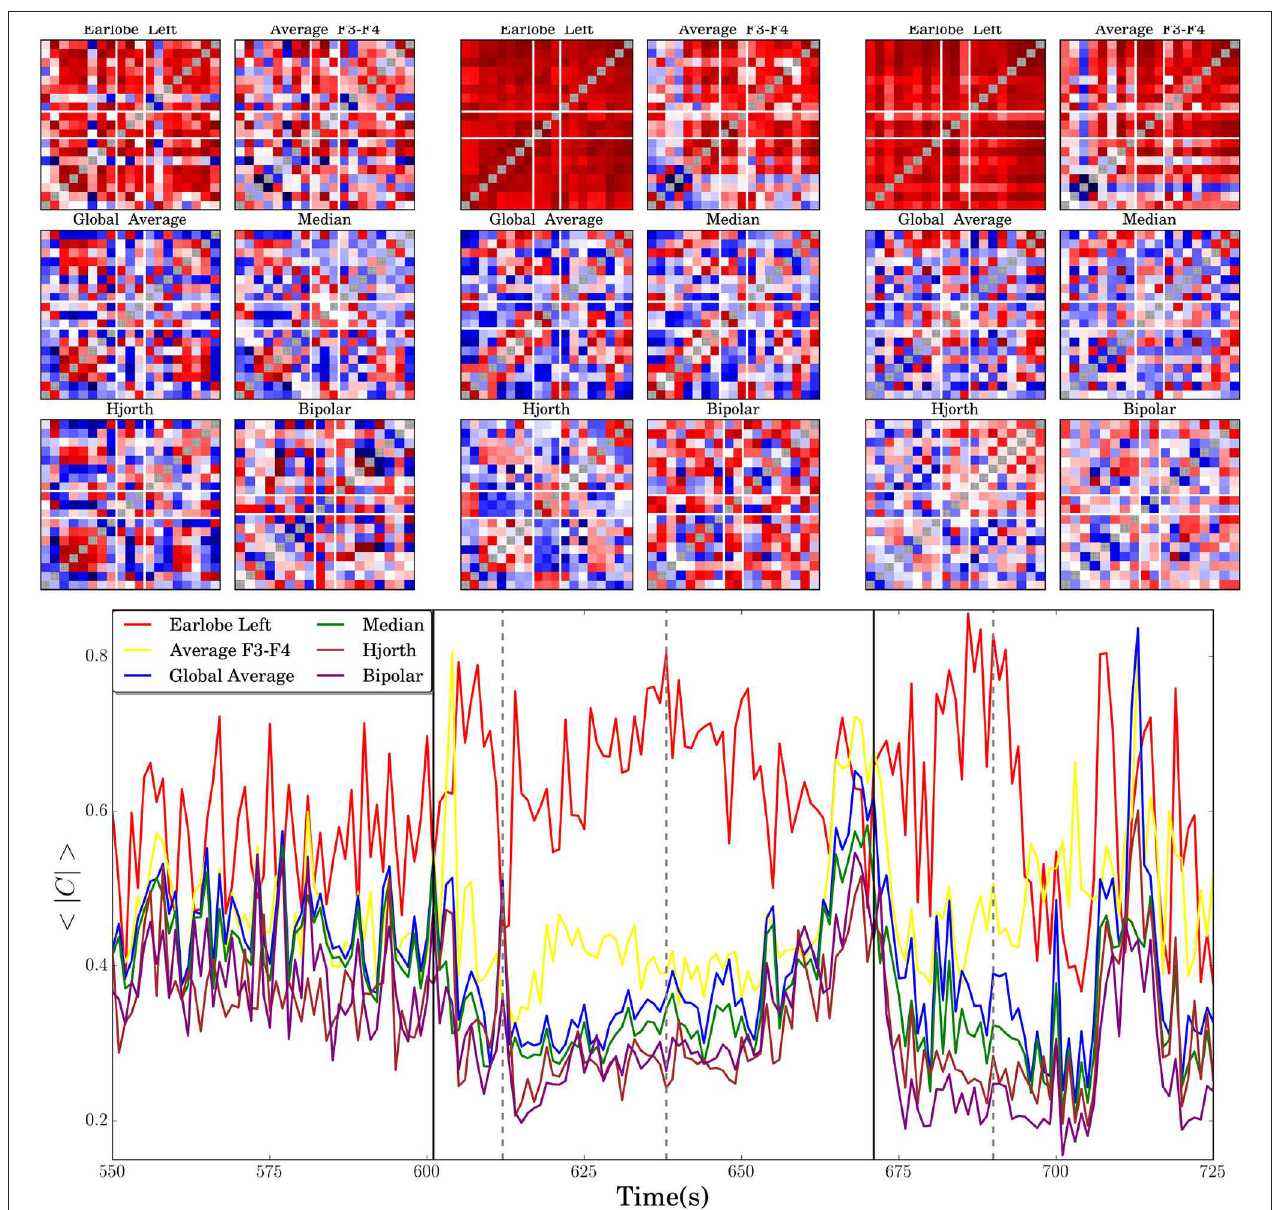
C , estimated for an h| |i